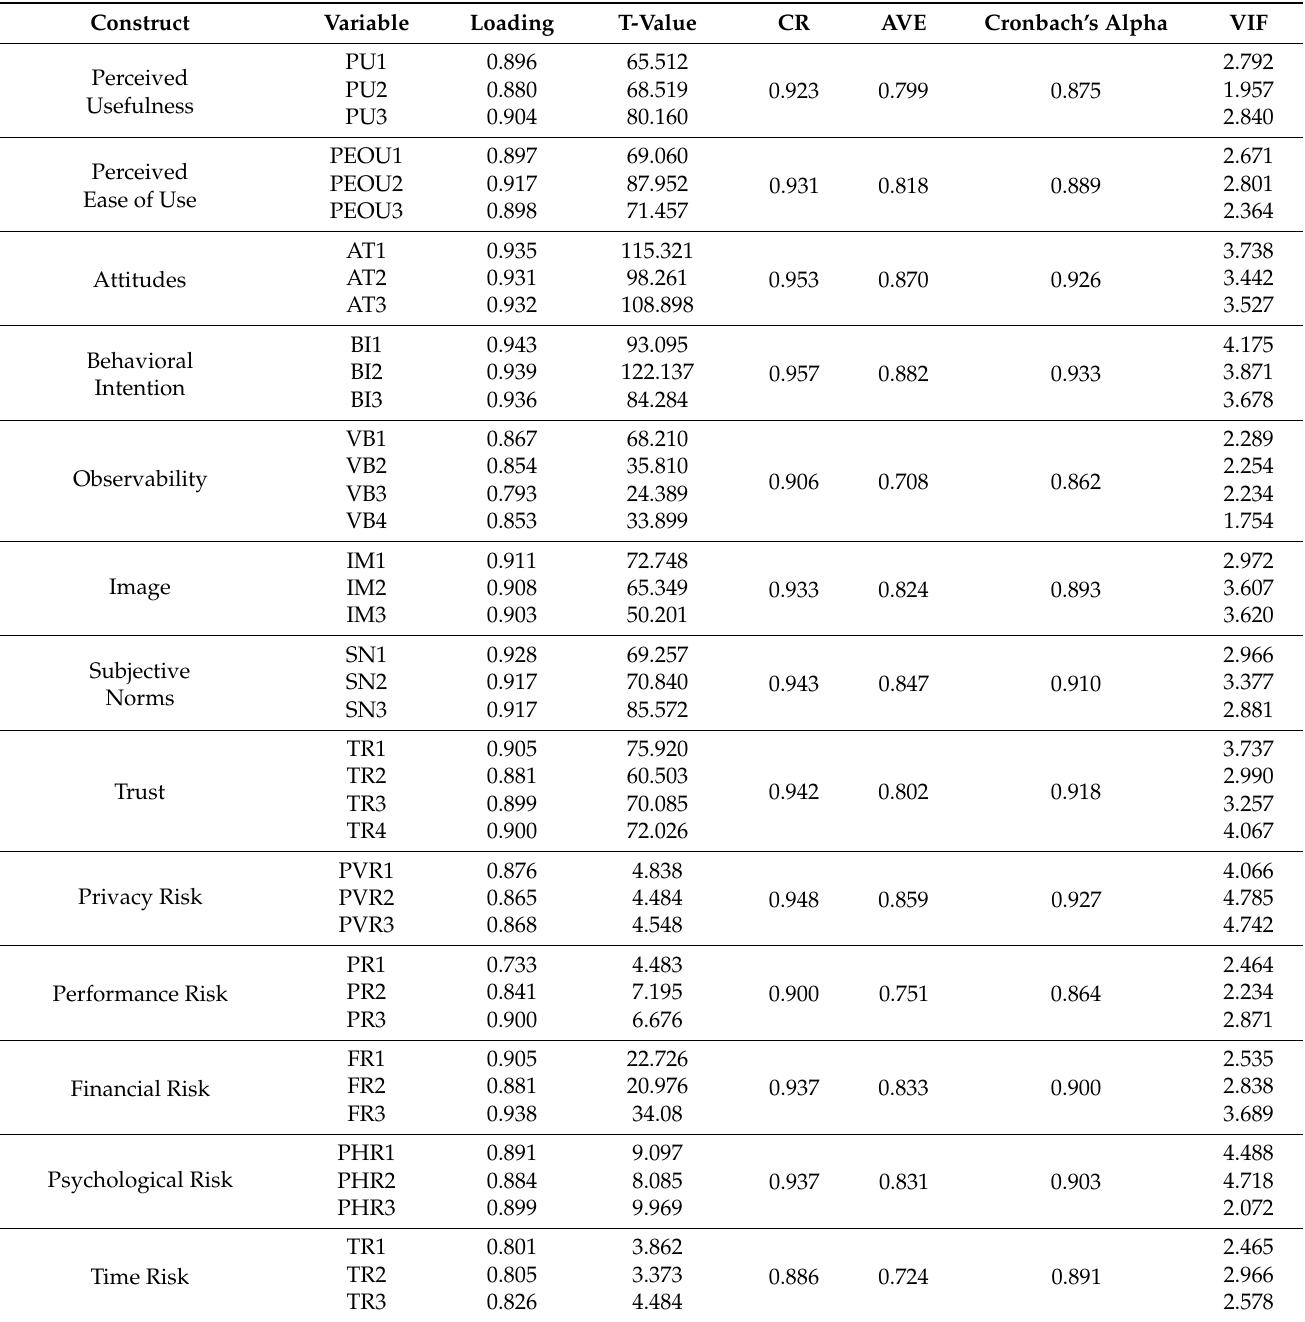
Table 1. Reliability and convergent validity of